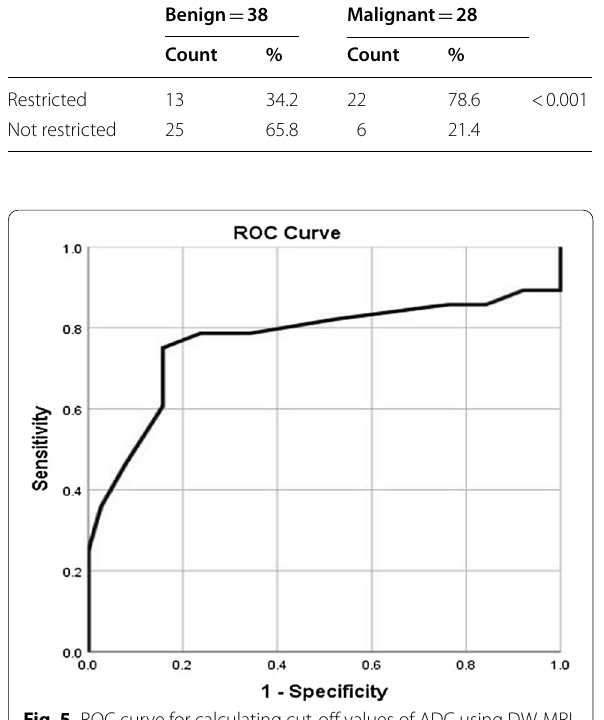
Fig. 5 ROC curve for calculating cut-off values of ADC using